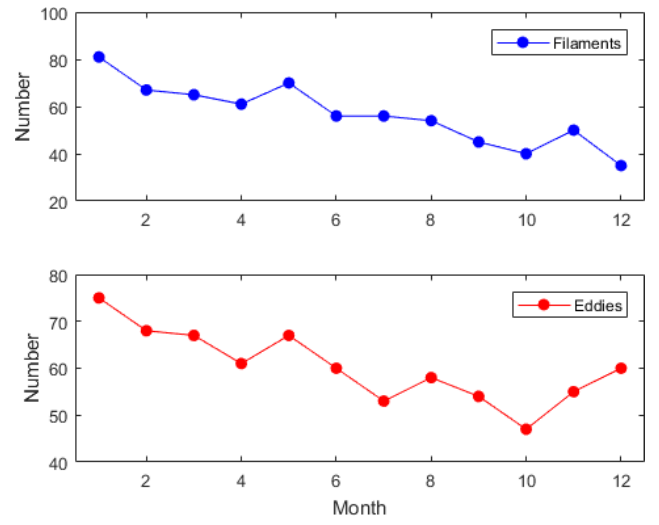
Figure 5. Numbers of warm filaments ( upper panel ) and mesoscale eddies ( lower panel ) that occurred in each month. The count of eddies is based on Chelton’s eddy